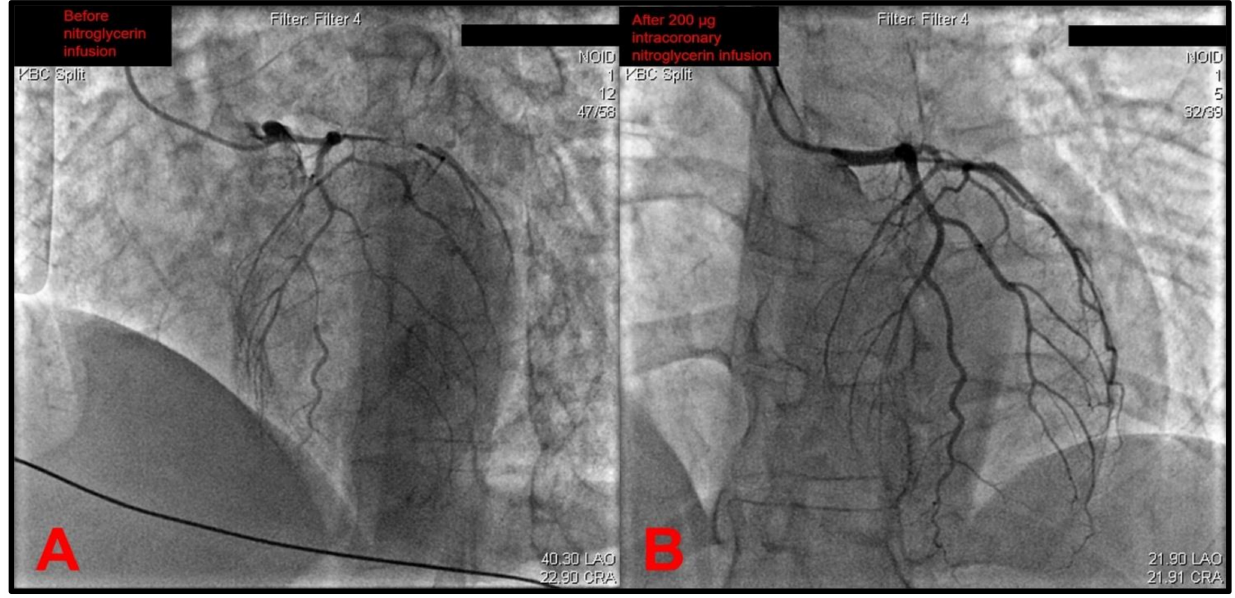
Figure 2. ( A ) An emergent coronary angiography revealed no atherothrombotic occlusions and a gracile aspect of the whole left coronary tree with most probable differential diagnoses of severe diffuse coronary vasospasm or extensive intramural hematoma due to a spontaneous coronary artery dissection (SCAD)—in this case originating from the left main stem. ( B ) Distal coronary flow signifi- cantly improved after an intracoronary infusion of 200 micrograms of nitroglycerin. Note: operator name, patient information, and procedure date have been de-identified from the original